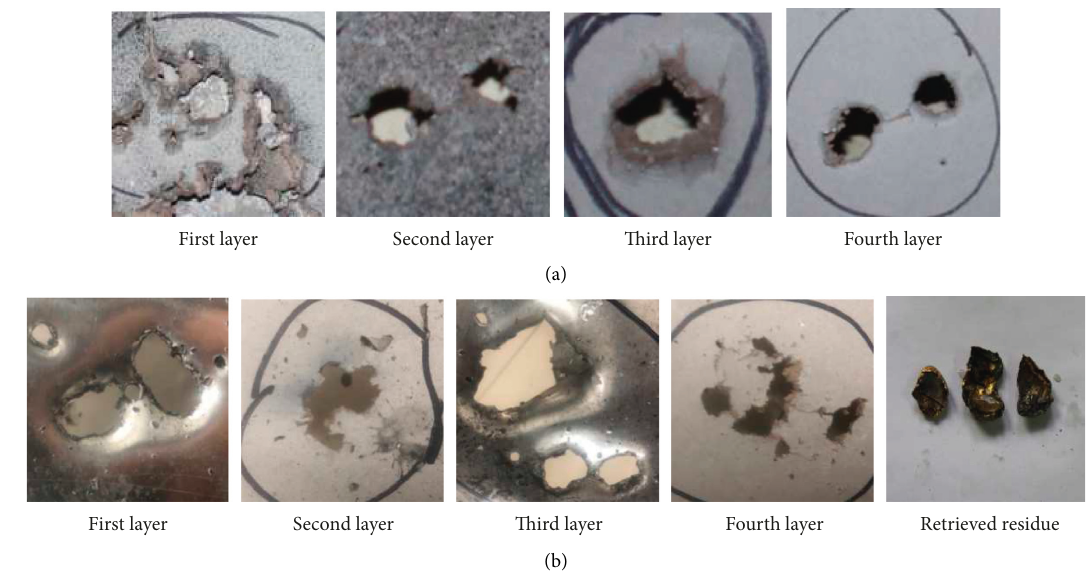
Figure 7: Perforation morphologies of the target plates from tests. (a) A-2# and (b)